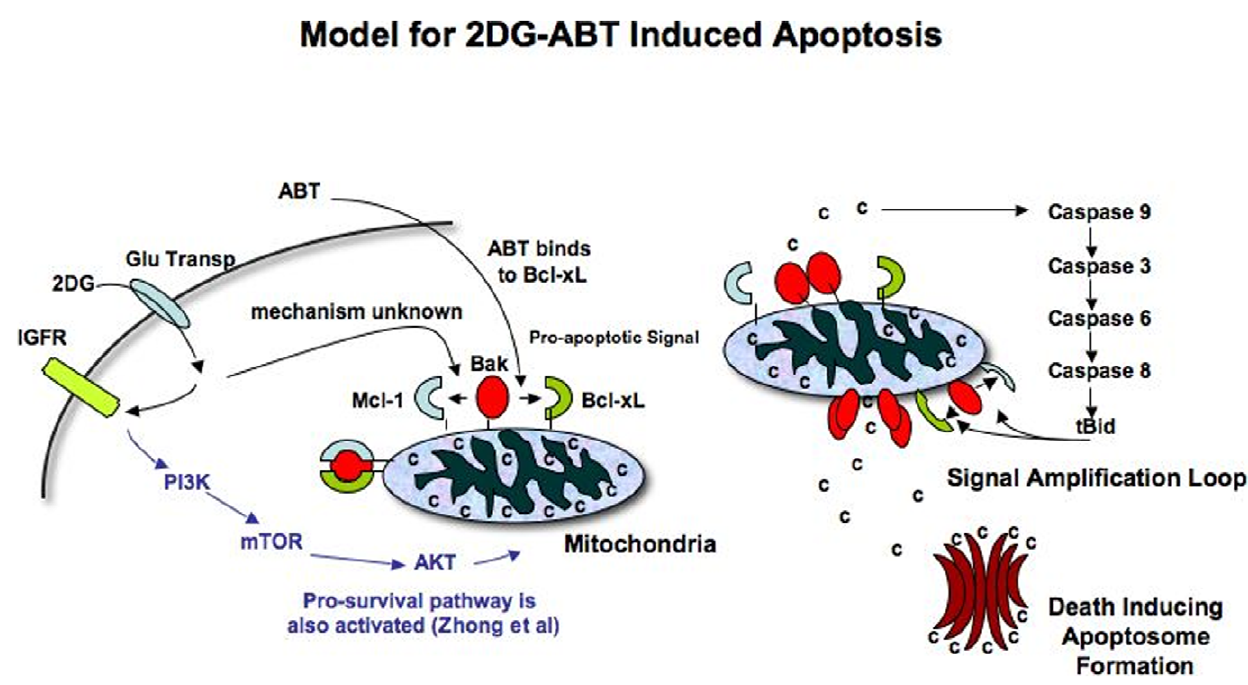
Figure 6. Model of 2DG-ABT Induced Apoptosis. a, 2DG is specifically taken up by cancer cells through a glucose transporter. Once inside, it is phosphorylated and becomes a hexokinase inhibitor. At the same time, it activates several signal transduction cascades. One of them is IGFR-PI3K- mTOR-AKT pro-survival pathway. Through another cascade activation, Bak-Mcl-1 association is lost. When ABT is added 3 hours later, it can bind to Bcl-xL and disrupts its association with Bak. b, Freed Bak oligomerizes, releasing a small amount of cytochrome c into the cytosol. It activates cascades of caspases 9-3-6-8 and caspase 8 cleaves Bid, generating BH3 only tBid protein. Since tBid can dissociate Bak-Mcl-1 and Bak-Bcl-xL association, it induces mitochondria outermembrane pore formation through which more cytochrome can be released. Released cytochrome c recruits Apaf1, caspase 9 and dATP, forming a ‘‘death executioner’’ apotosome complex.